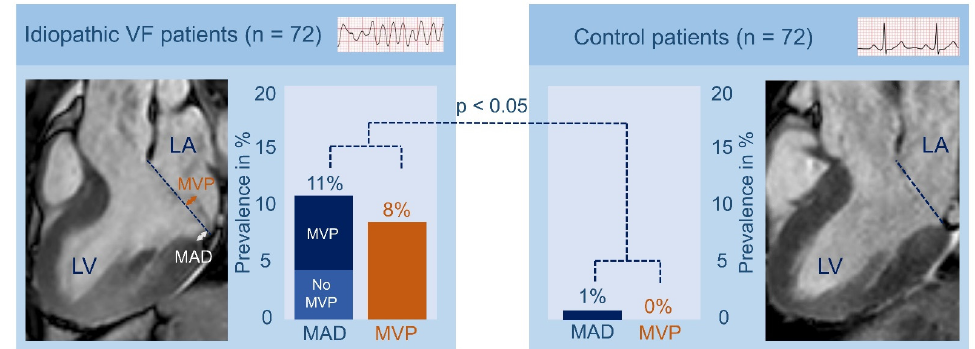
Figure 5. Prevalence of mitral valve prolapse and mitral annulus disjunction in idiopathic ventricular fibrillation patients. Mitral valve prolapse (MVP) and mitral annulus disjunction (MAD) were significantly more prevalent in idiopathic ventricular fibrillation patients compared with control patients. MVP is defined as “the displacement of >2 mm of one or both leaflets beyond the annular hinge points at end systole”; MAD is defined as “longitudinal displacement of >1 mm”. LA: left atrium; LV: left ventricle; VF: ventricular fibrillation. Adapted with permission from Groeneveld et al. [67].